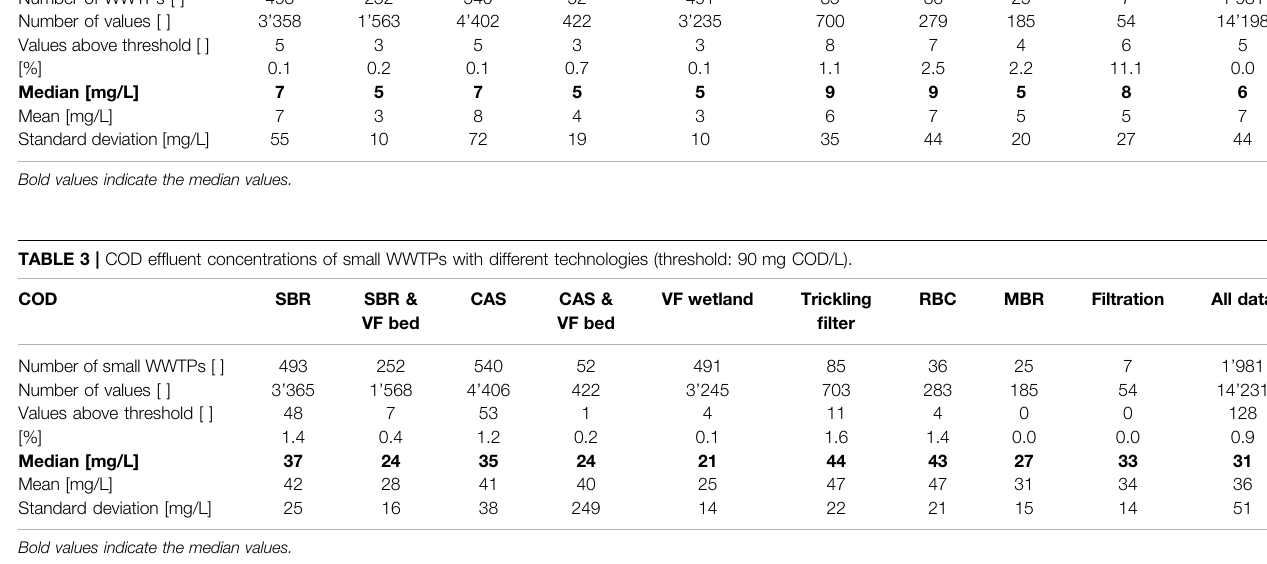
TABLE 2 | BOD 5 ef fl uent concentrations of small WWTPs with different technologies (threshold: 25 mg BOD 5 /L). BOD 5 SBR SBR & Number of WWTPs [ ]